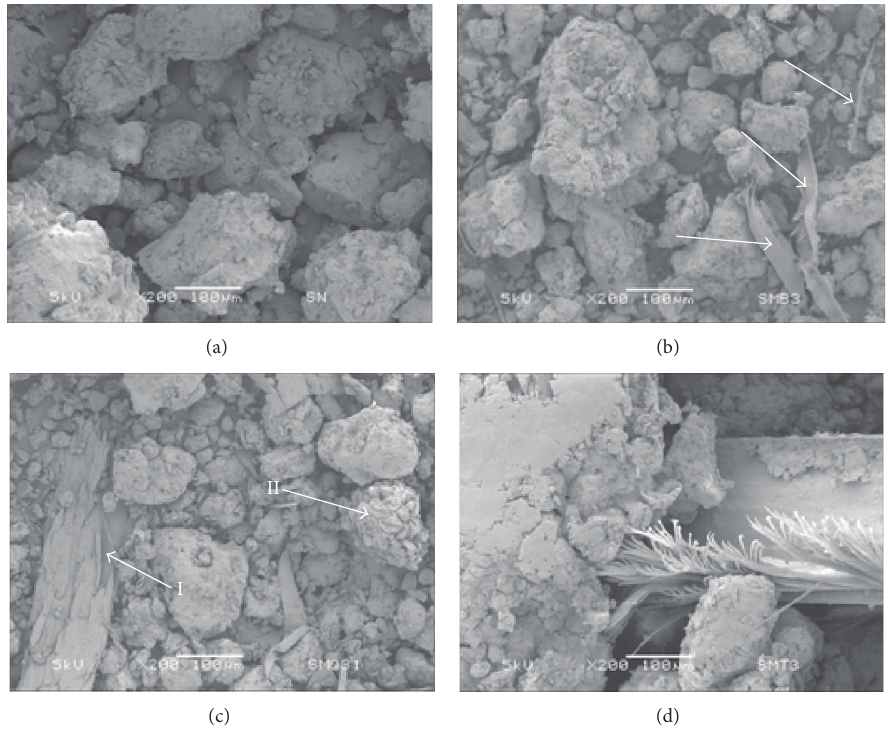
Figure 8: SEM micrographs of SN (a); SMB-3% (b); SMQ-3% (c); and SMT-3%